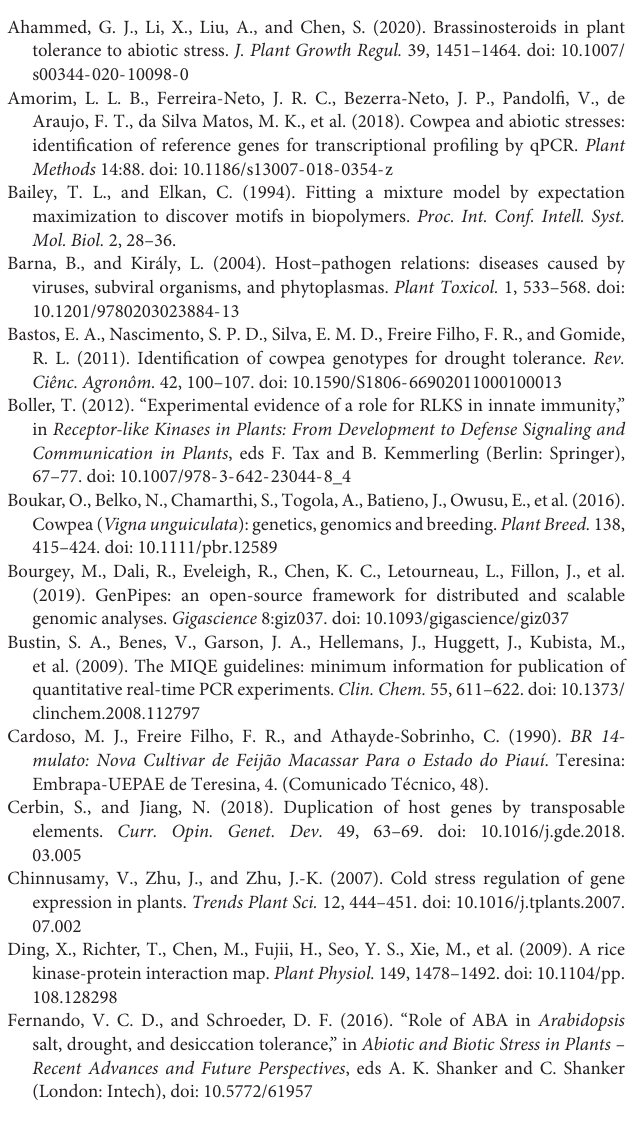
Supplementary Table 7 | Mechanisms of origin of 1,293 loci encoding bona fide VuPKs in the cowpea genome. The asterisk indicates duplication mechanism. Supplementary Table 8 | K a , K s , and K a / K s ratio values and number of introns for the 190 gene pairs of bona fide VuPKs originated via tandem duplication. Supplementary Table 9 | Species with genome deposited in the Phytozome database, presenting their respective plant family and the number of orthologous loci to the bona fide VuPKs searched in the cowpea genome. Supplementary Table 10 | Bona fide cis -regulatory candidate elements anchored in the promoter regions of genes encoding VuPKs from different families in the RLK-Pelle group, with information on their consensus motif and associated transcription factors (Matrix JASPAR ID). CCREs, candidate cis -regulatory elements. Supplementary Table 11 | Transcriptional regulation of the 1,178 isoforms of bona fide VuPKs differentially expressed in at least one of the treatments